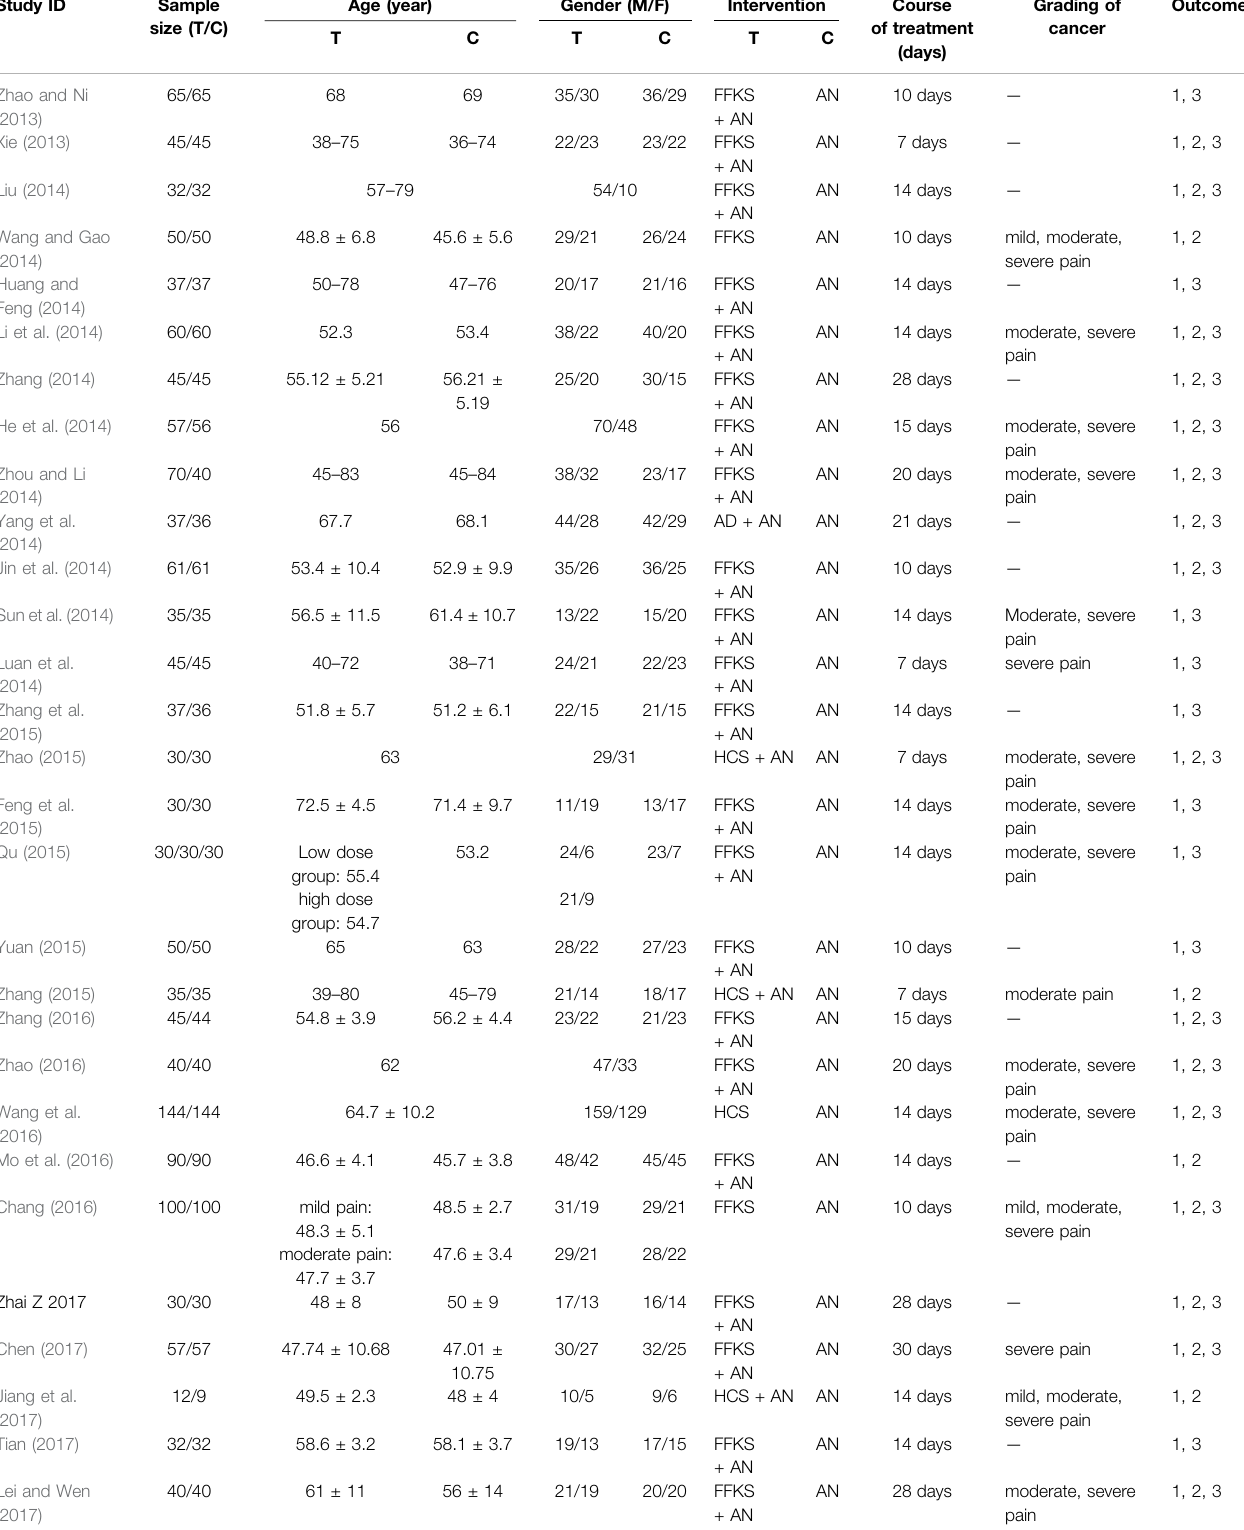
TABLE 1 | ( Continued ) Characteristics of the included randomized controlled